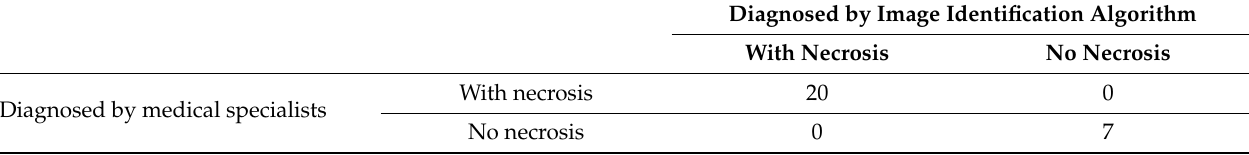
Table 4. The result of determination of wound depth ( n = 27) with medical specialists vs. image identification algorithm.